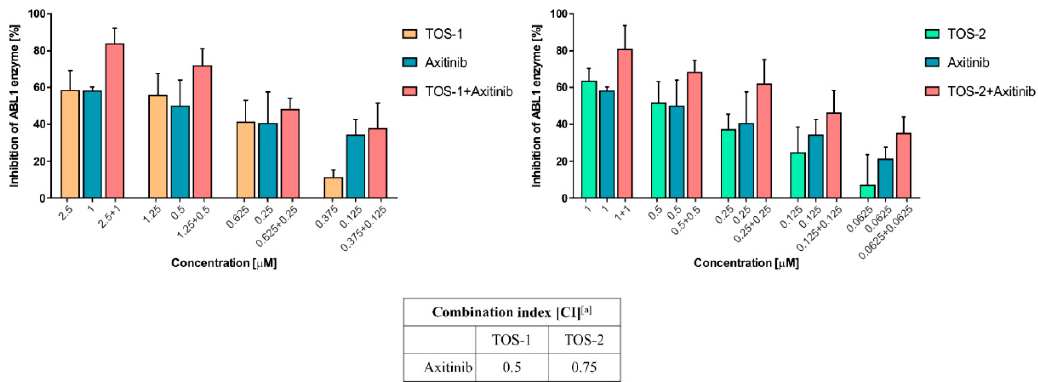
Figure 4. Inhibition of the ABL1 enzyme by TOS-1, TOS-2 and their combination with axitinib. The combination indexes (CI) for the combinations of the TOS derivatives and axitinib were calculated using CompuSyn software; [a] for Fa = 0.9, CI > 1 – antagonism, CI = 1 – additivity, CI < 1 – synergy.